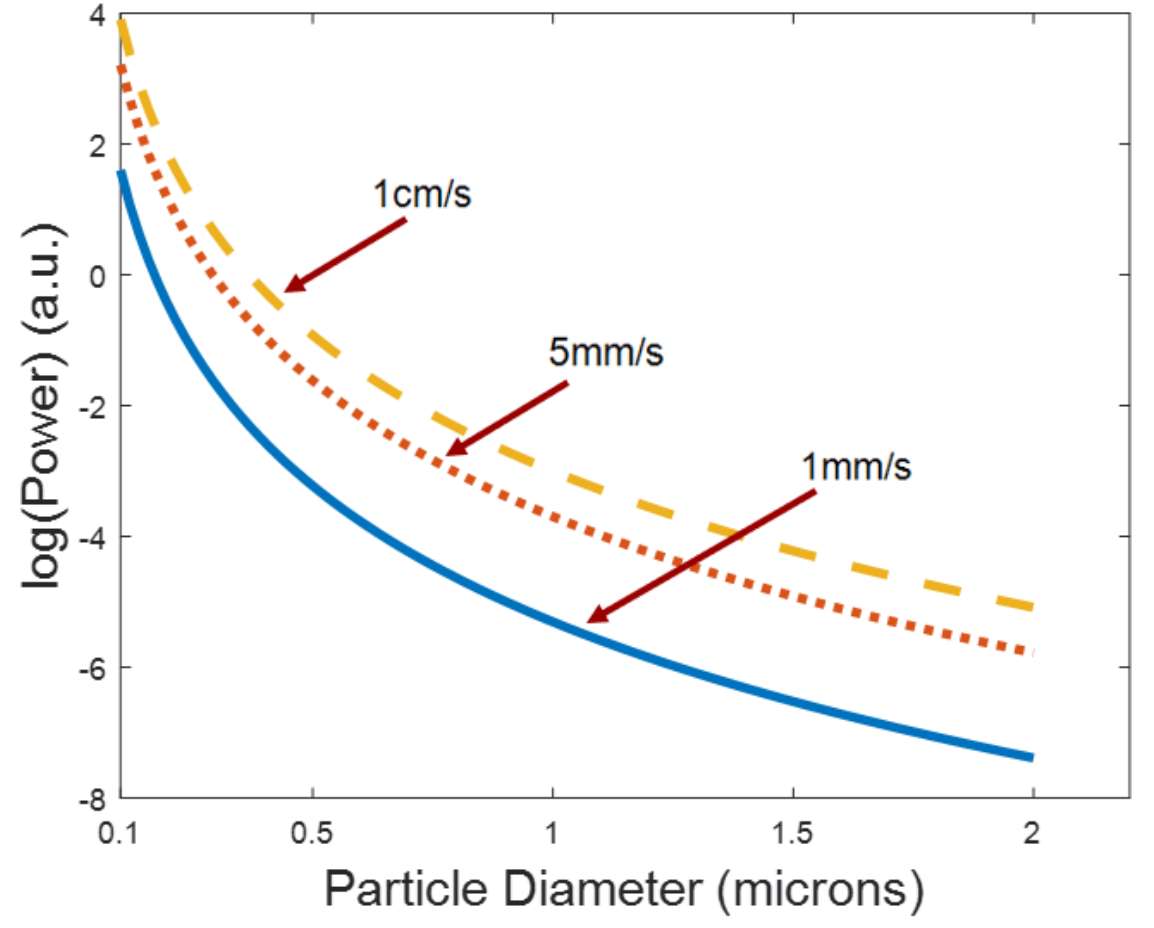
Figure 11. Minimum optical power for trapping of various sized particles. This is measured as power into the chip from the laser source. Typical SC waveguide lengths are between 3 – 4 mm with an average loss of 0.50 cm − 1 . Multiple flow velocities represented.